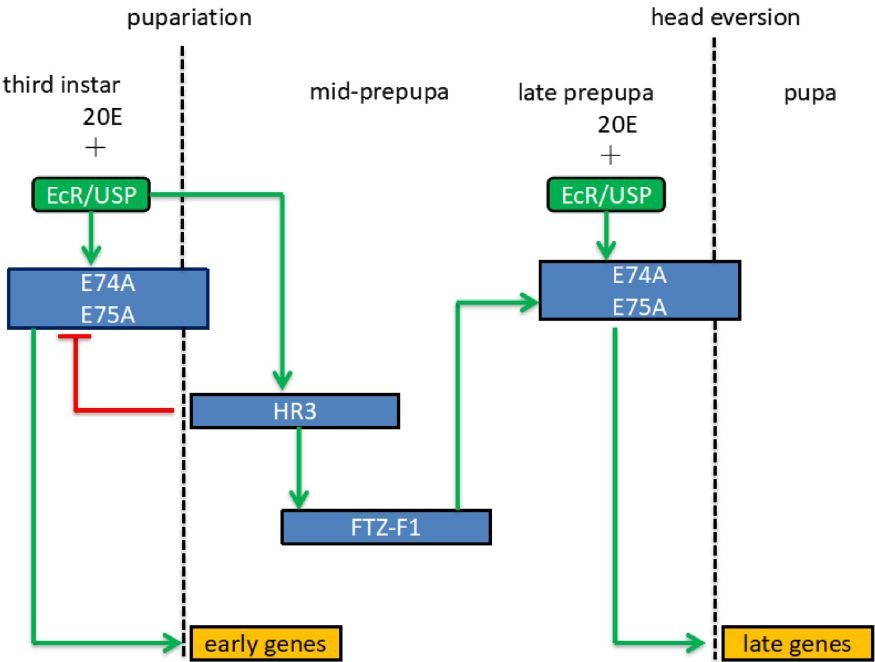
Fig 10. Schematic diagram of ecdysone 20E signal transduction. From the 3rd instar larva to the early pupation stage, 20E regulates the expression of E74A and E75A by binding to the receptor EcR/USP, thus initiating the early pupation-related gene expression. During the mid-prepupa period, 20E regulates HR3 expression by binding to the receptor EcR/USP, and HR3 accumulation inhibits the expression of E74A and E75A, thus turning off early pupation- related gene expression. During the late prepupa period, HR3 regulates the expression of E74A and E75A through FTZ-F1, thereby initiating the expression of late pupation-related genes.